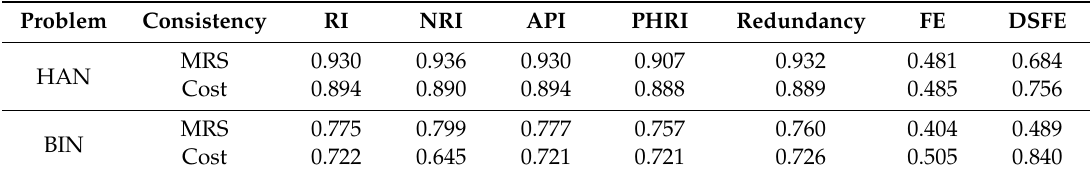
Table 3. Consistency values between cost / reliability and surrogate indicators.